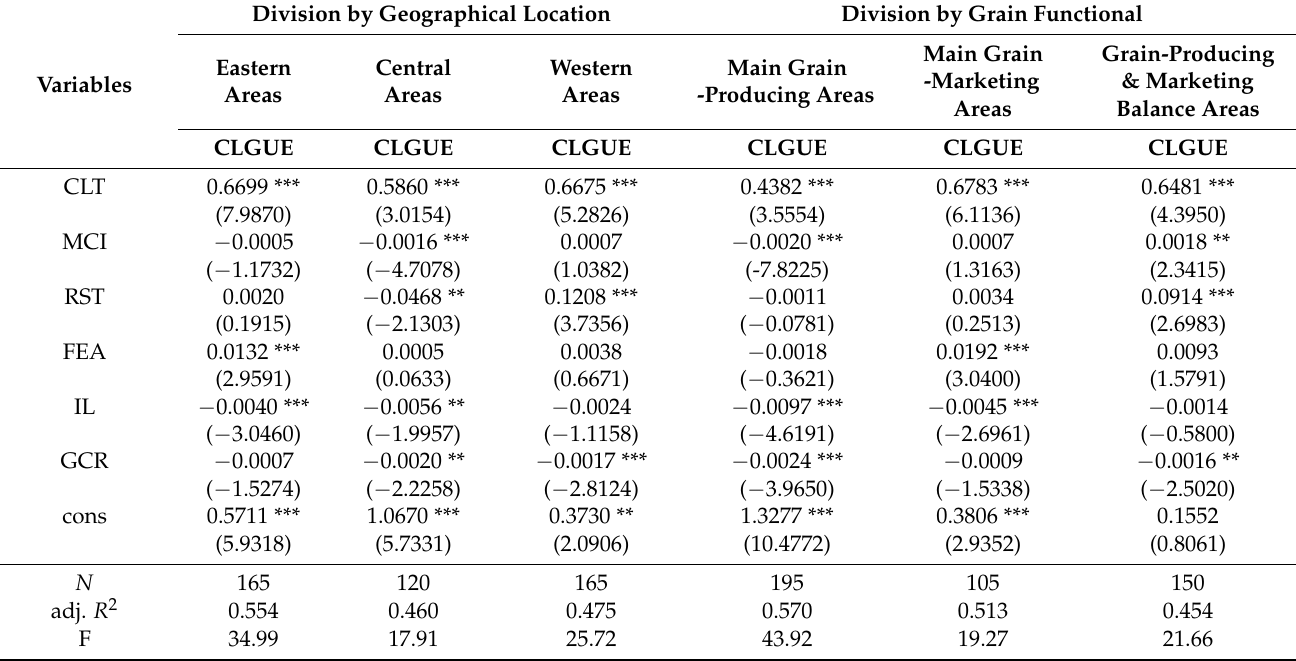
Table 7. Heterogeneity analysis of effects of CLT on